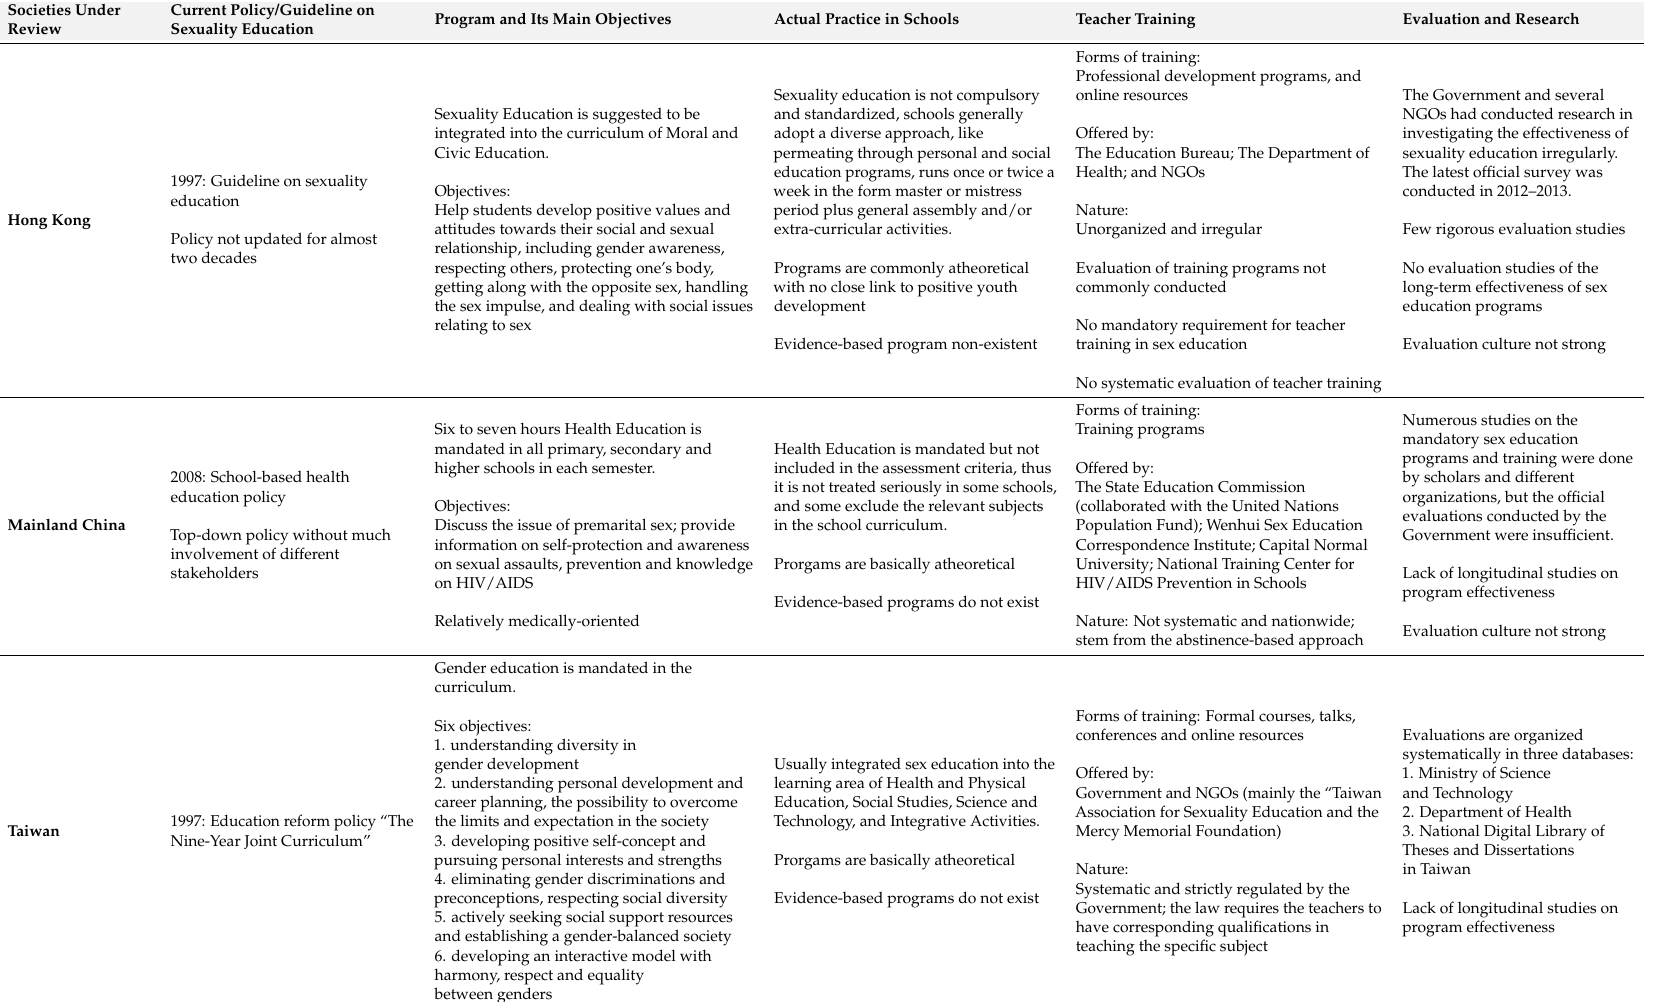
Table 2. Summary of sex education aspects in the three Chinese-speaking